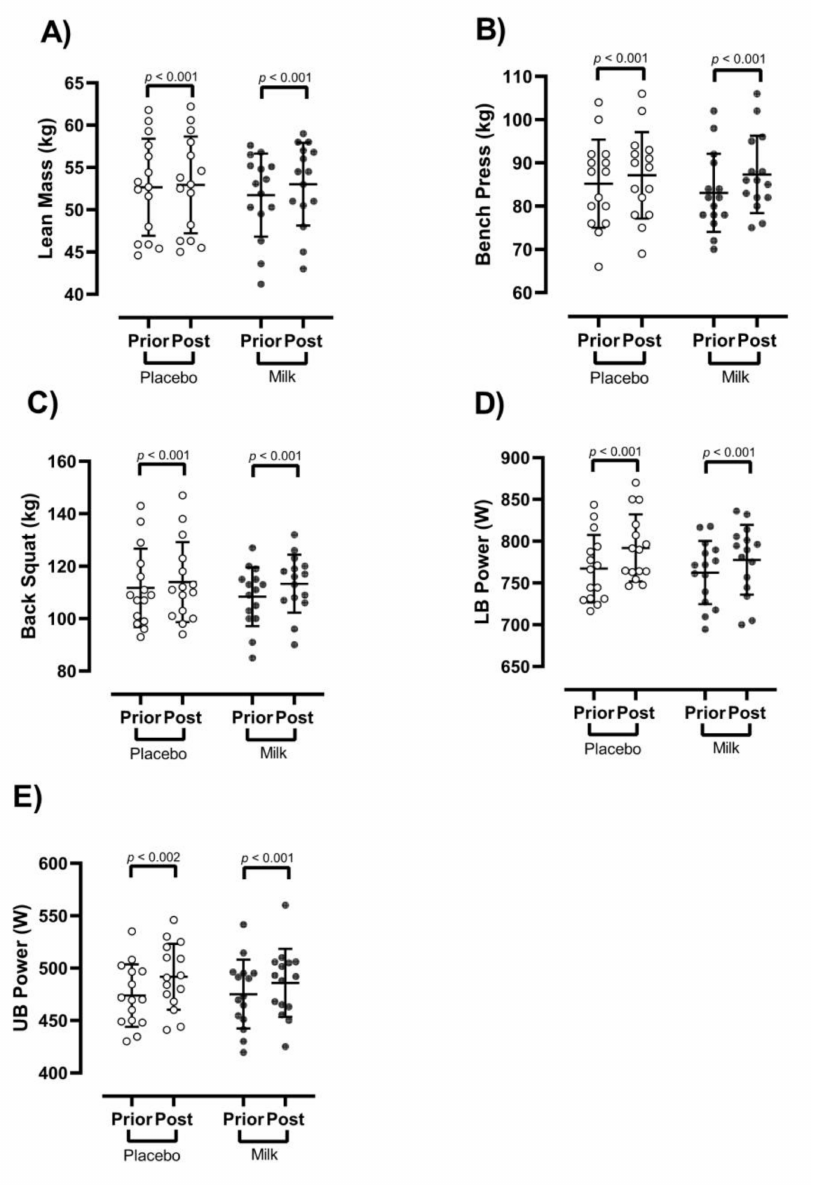
Figure 2. Effect of resistance training and groups on training-induced changes. ( A ) Lean mass (kg), ( B ) bench press (kg), ( C ) back squat (kg), ( D ) lower body power—LB power, (W), ( E ) upper body power—UB power, (W). n = 15 per group, error bars represent standard deviation, open white circles indicate placebo group, closed black circles indicate high-protein diary milk ingestion